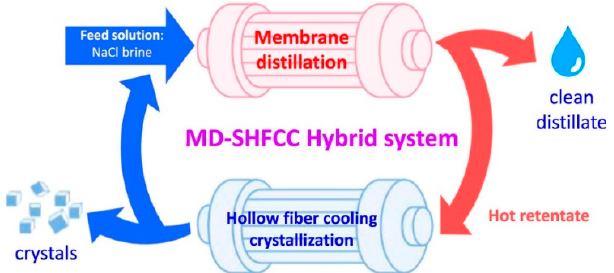
Figure 14. Schematic diagram for the integrated forward osmosis-membrane distillation process for human urine treatment. Reprinted from [104] Copyright (2016) with permission from Elsevier .